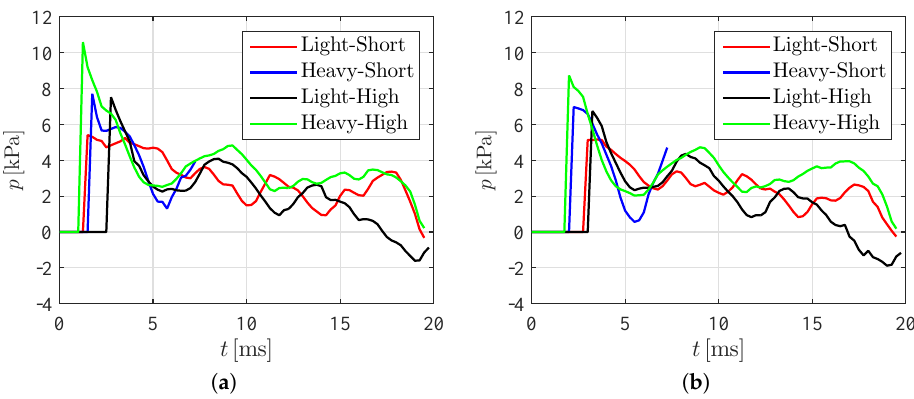
Figure 9. Hydrodynamic loading for different conditions at ( a ) 5 mm and ( b ) 10 mm away from the keel. Note that we only present results before failure for the VE220-60 panel falling from 40 cm.